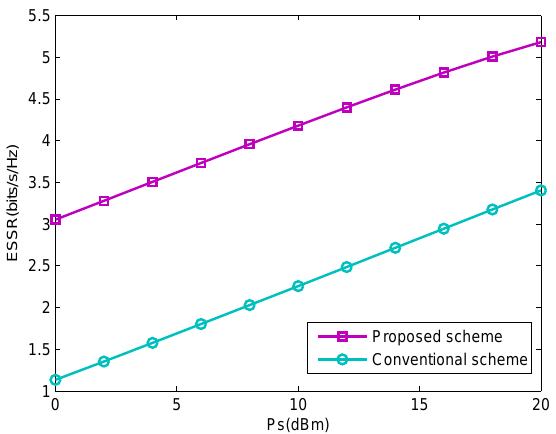
Figure 6. ESSR versus the whole transmit power P s with different